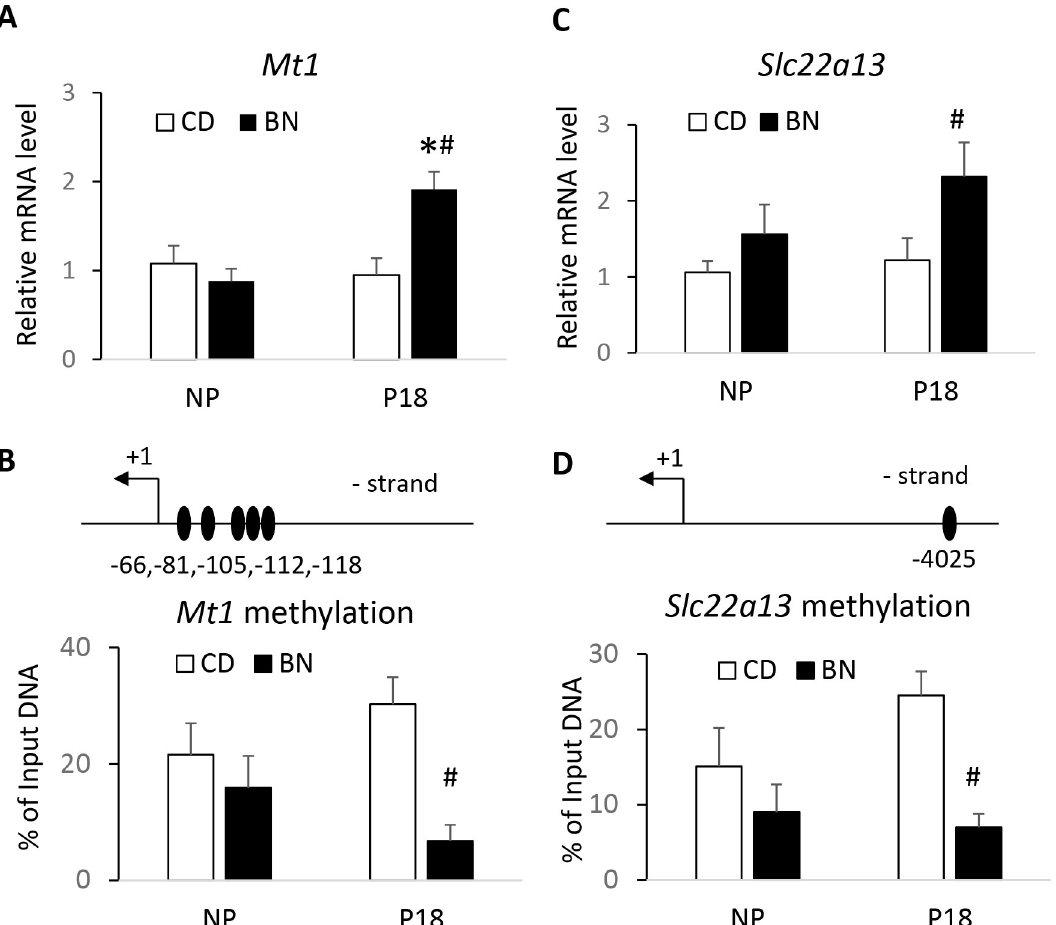
solute carrier organic cationic transporter family 22 member 13 ( Slc22a13 ). mRNA levels are shown as fold of CD NP values, and % methylation is calculated as % of input gDNA levels. The number and position, relative to the TSS, of the CpGs studied is also shown. Bars represent the average ± error, n = 5 rats/group. � p < 0.05 P18 vs NP, # p < 0.05 BN vs CD.